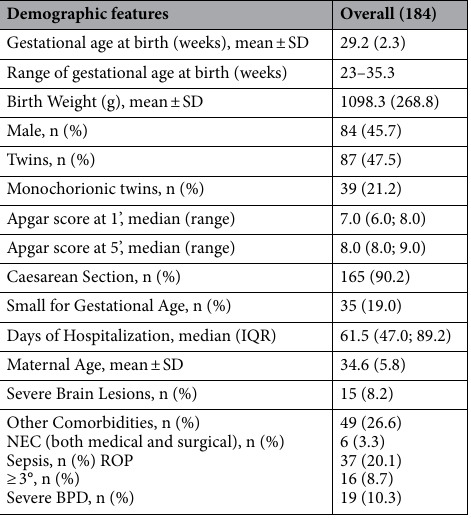
Table 1. Baseline characteristics of the population included in the study. NEC (necrotizing enterocolitis); ROP (retinopathy of prematurity); BPD (bronchopulmonary